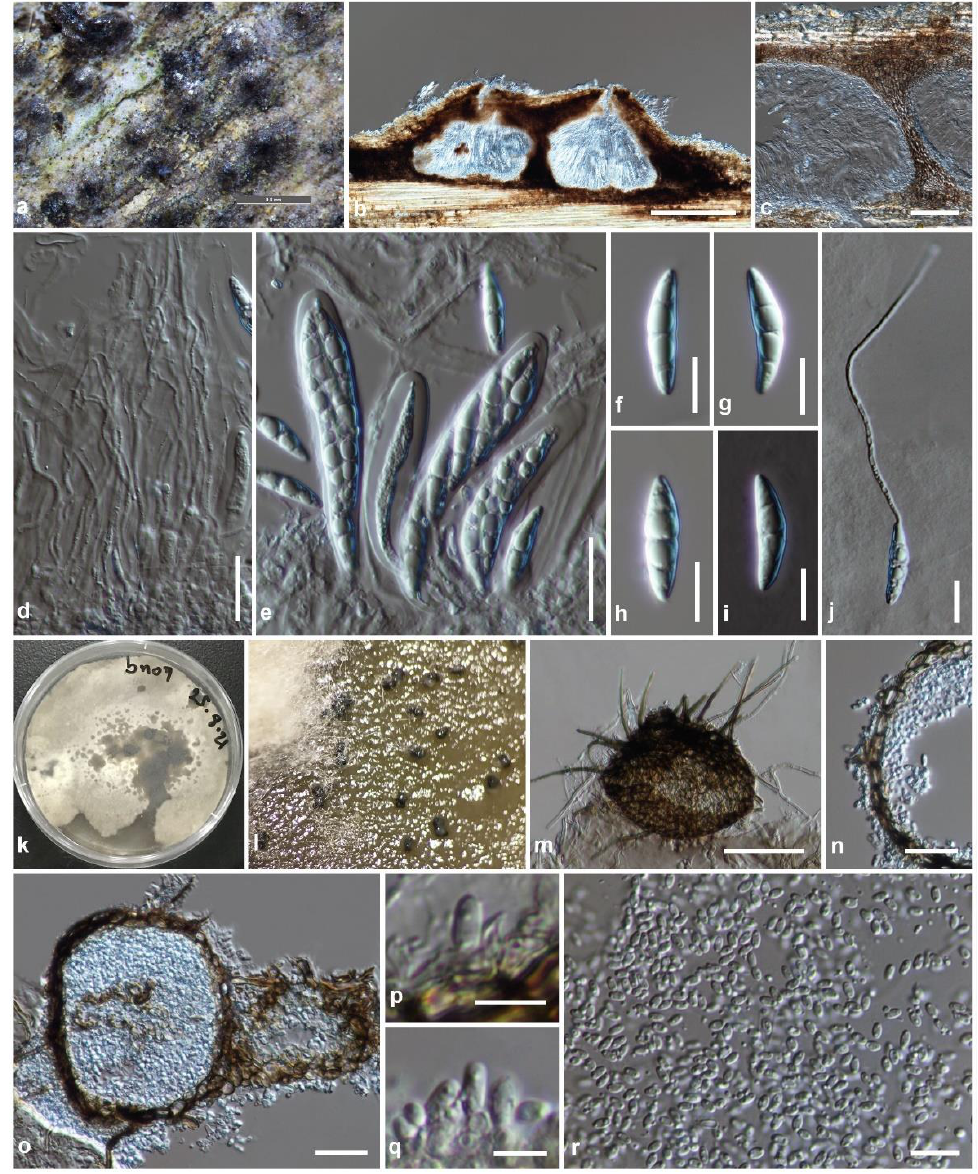
Figure 7. Pyrenochaetopsis yunnanensis (KUN-HKAS 123172, holotype). ( a ) The appearance of ascomata on host substrate; ( b ) Vertical section of ascomata; ( c ) Peridium; ( d ) Pseudoparaphyses; ( e ) Asci; ( f – h ) Ascospores; ( i ) Ascospore stained with Indian ink; ( j ) Germinated ascospore; ( k ) Colony sporulated on PDA after two months; ( l ) Conidiomata immersed or superficial on PDA; ( m ) Squash mount of conidioma in water; ( n ) Section through pycnidial wall; ( o ) Vertical section of conidiomata; ( p , q ) Conidiogenous cells; ( r ) Conidia. Scale bars: ( b ) = 200 μ m, ( c , m ) = 50 μ m, ( d , e , n , o ) = 20 μ m, ( f – i , j , r ) = 10 μ m, ( p , q ) = 5 μ m.